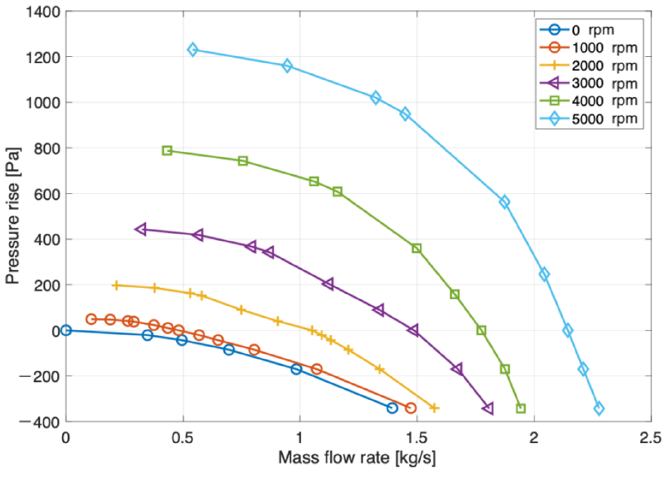
Figure 10. Cooling system fan map.